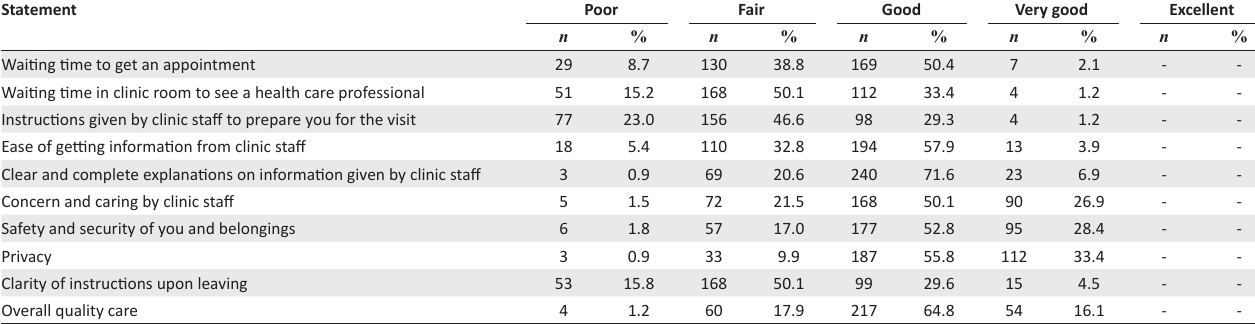
TABLE 1 : Satisfaction with the quality care scores of patients with type 2 diabetes mellitus ( n = 335)